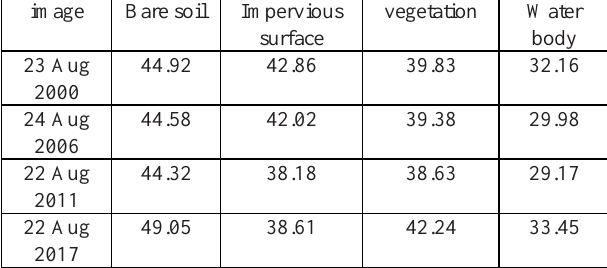
Table 4. LULC types average LST